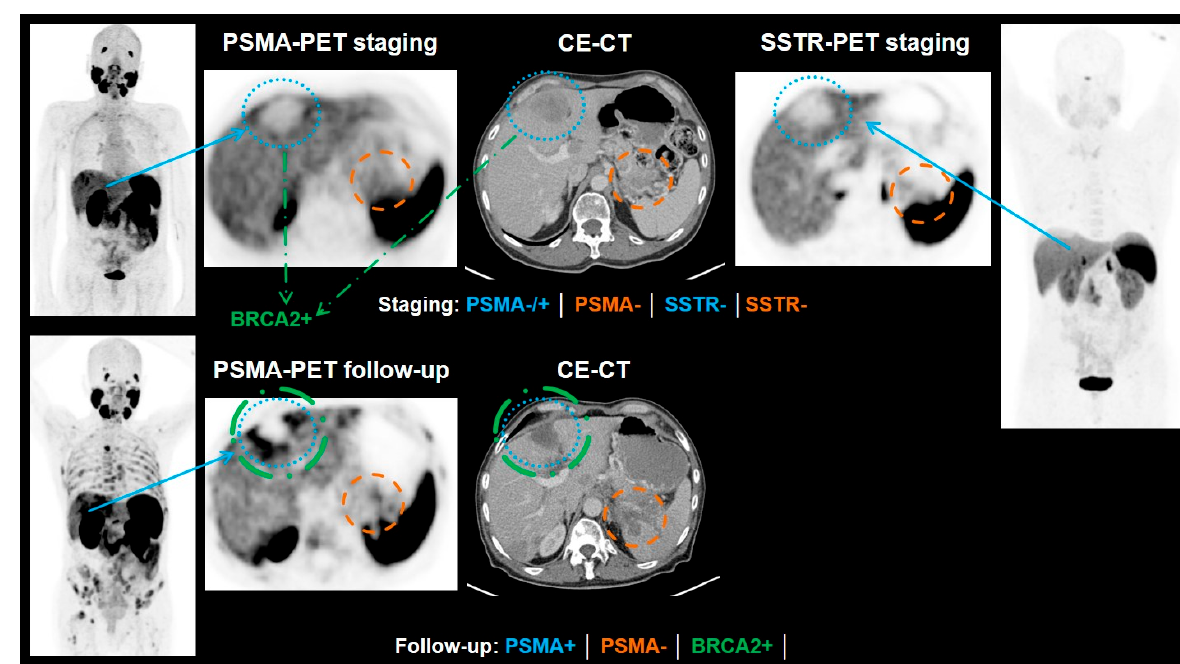
Figure 5. Example of a patient with neuroendocrine differentiated prostate cancer. At the time of the staging PSMA-PET, the patient had already tested positive for neuroendocrine differentiation of the prostate cancer. The PSA value had been below the detection rate. In the PSMA scan, the liver metastases showed only a PSMA expression similar to the liver uptake or only slightly above liver uptake (blue). A metastasis in the pancreas showed no PSMA expression (orange). An additional SSTR-PET was performed where no SSTR expression of the liver metastases (blue), nor was the pancreas metastasis (orange) detectable. After another biopsy of the marked liver metastasis, a BRCA2 mutation could be confirmed (green). The patient underwent chemotherapy with etoposid and cisplatin as well as an immunotherapy with olaparib. In the follow-up PSMA-PET, the patient presented with progressive disease, but the BRCA2-positive metastasis decreased in size (the lesion was additionally treated with Gamma Knife) and showed a higher PSMA expression than before (blue, green). In contrast, the metastasis of the pancreas increased in size and showed still no PSMA expression. CE-CT = contrast-enhancement computed tomography, PSMA = prostate-specific membrane antigen, SSTR = somatostatin